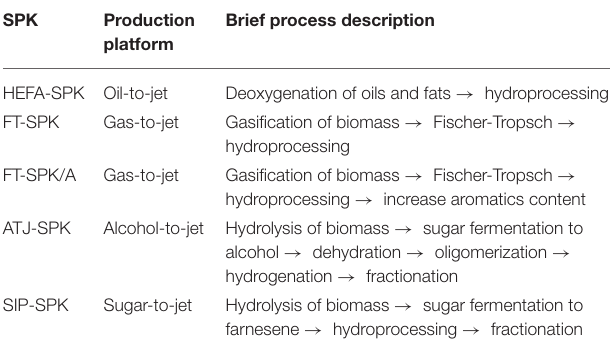
TABLE 1 | Five types of synthetic paraffinic kerosene based on the production platform (Wang and Tao, 2016; Yang et al., 2019).